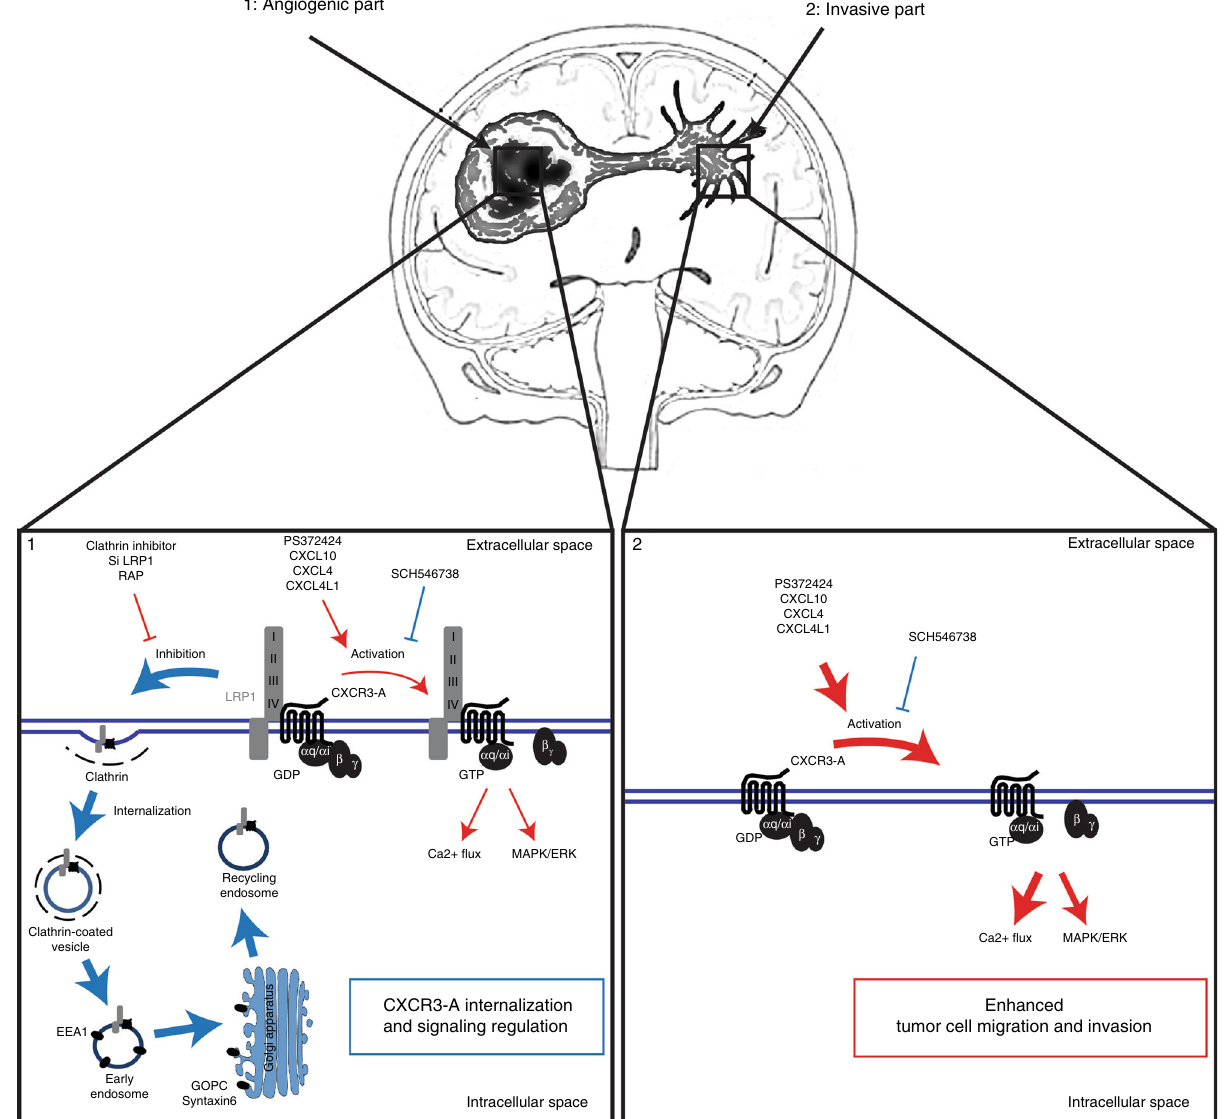
Fig. 10 Implication of CXCR3-A/LRP1 complex in glioblastoma invasion. Model describing the regulatory role of LRP1 on CXCR3-A function in the angiogenic core of the tumors and in the invasive areas. In contrast to the central core, LRP1 is downregulated in the invasive areas, which leads to an increase in glioblastoma